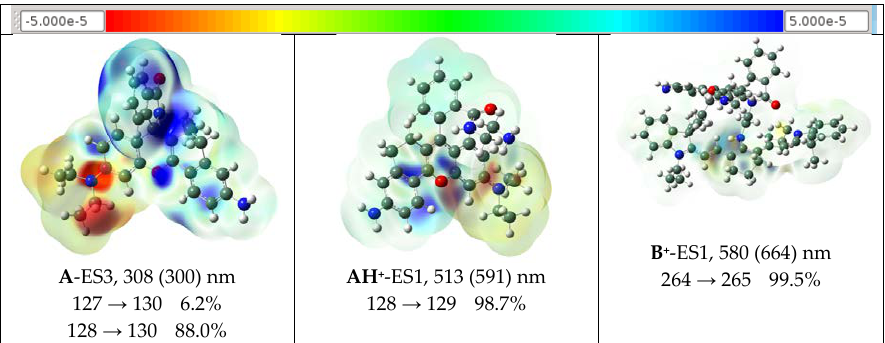
Figure 8. Fluorescence intensity of probes A and B + in the absence and presence of 50 µM different amino acid and biothiols at pH 4.0 and 11.3 under excitation of 450 nm for probe B + ( a ) and under 550 nm excitation for probe A ( b